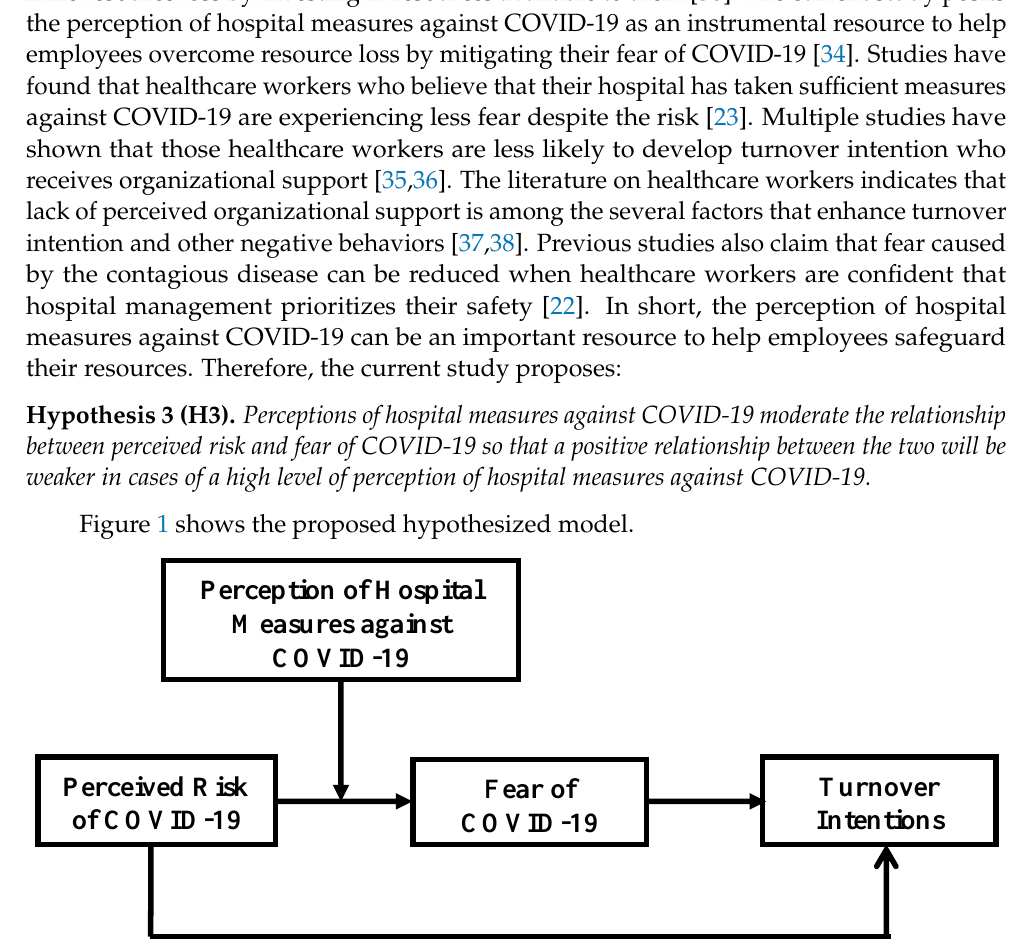
Figure 1. Proposed hypothesized model.